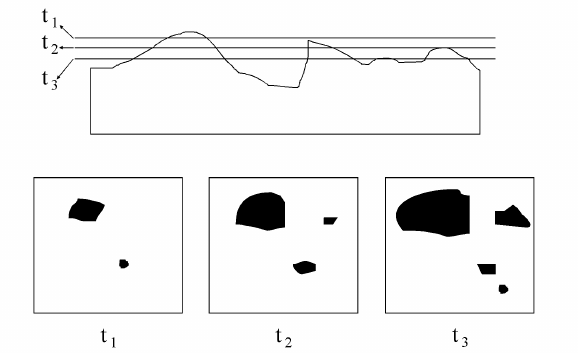
Figure 2. Schematic view of the procedure employed to reveal the ‘‘slit island structure’’. t 1 , t 2 and t 3 represent the evolution of the slit islands for increasing polishing times.